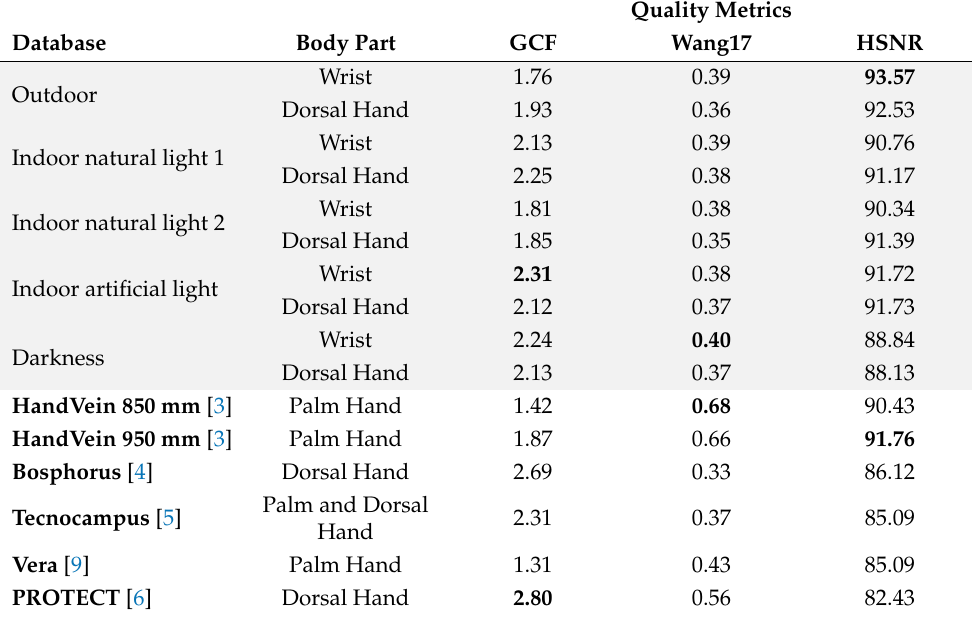
Table 5. Results of quality